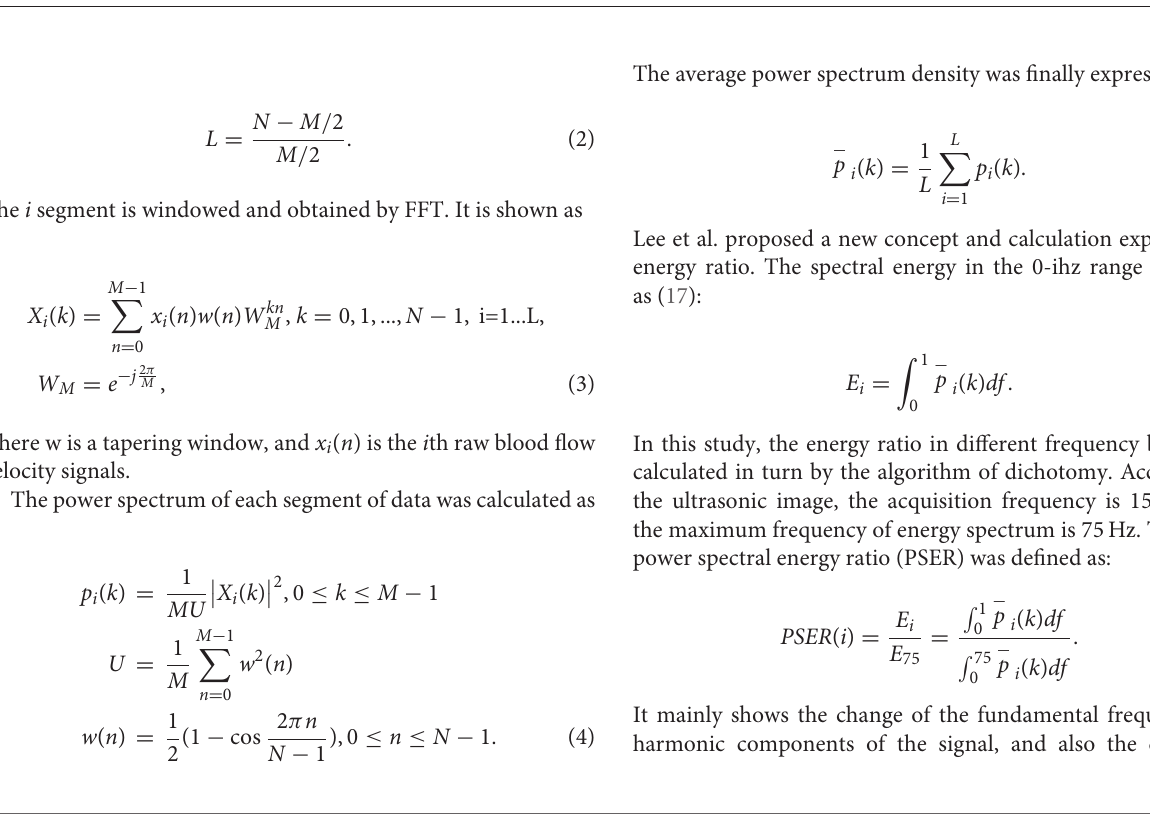
FIGURE 4 | Effect of EECP on the second peak amplitude (y2) of the RC and LC arteries (A,B) , RB artery (C) , and RF artery (D) in patients with CAD and controls before, during and after 45-min EECP. b indicates differences between post-EECP vs. during-EECP and c refers to comparisons between post-EECP vs. pre-EECP. “*” denotes value of p <